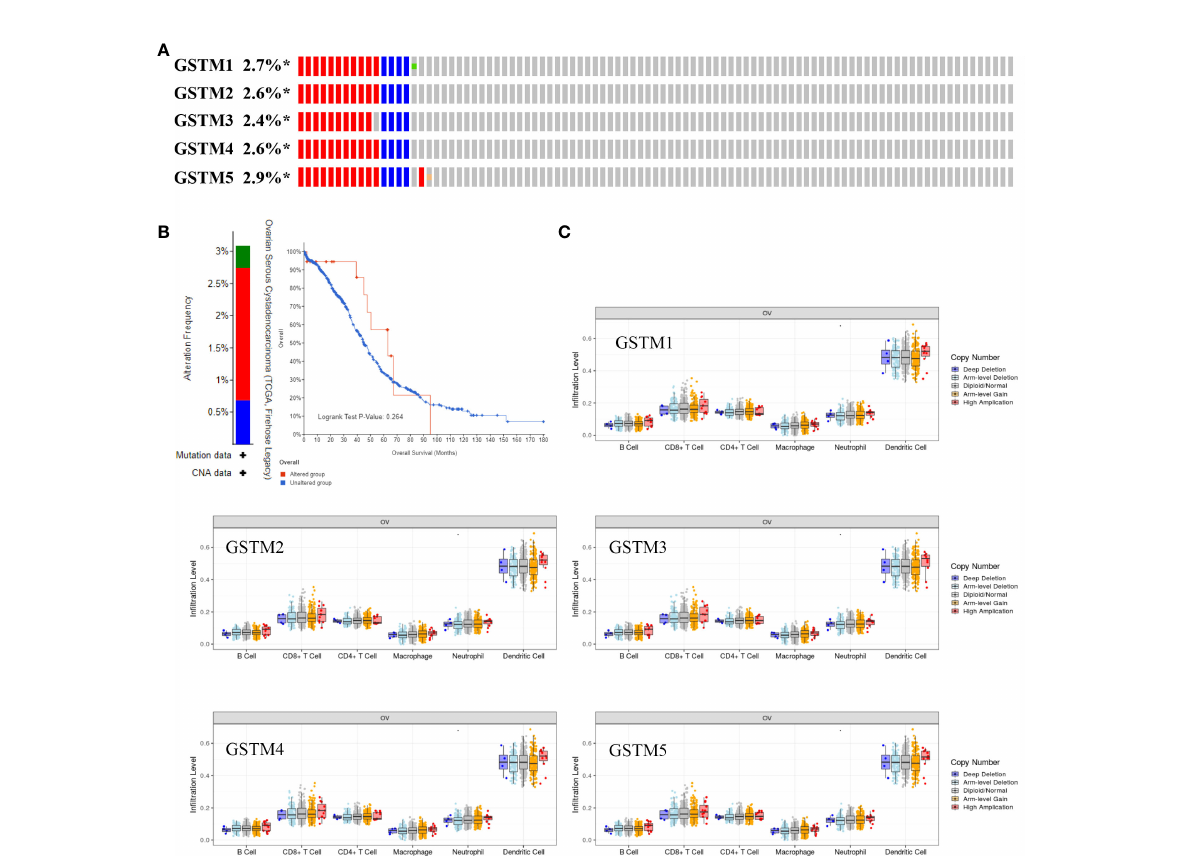
FIGURE 6 The correlation of immune in fi ltration and GSTMs alteration in OC. (A) The DNA alteration rate of GSTM1, GSTM2, GSTM3, GSTM4 and GSTM5 was more than 2% in OC. (B) The overall survival rate based on OC patients with and without these genes alteration based on the cBioPortal dabtase. (C) The effect of GSTM1-5 CNV on the immune cell distribution based on the TIMER database. *p <